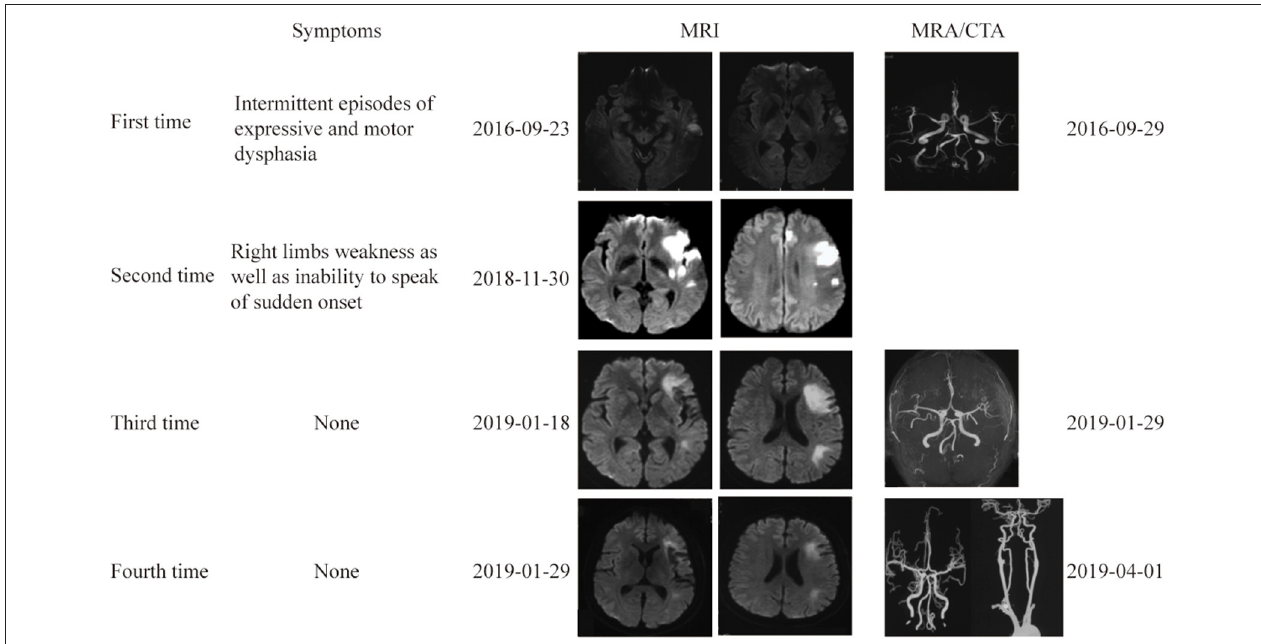
FIGURE 1 | Brain and vascular imaging at 4 different times. Brain MRI at 4 times showed multiple lesions in the left ICA territory. Vascular imaging showed no evidence of vascular stenosis or occlusion.